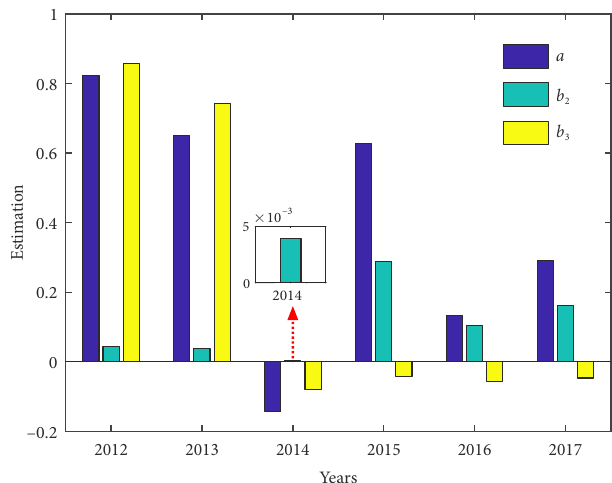
Figure 4. Description of model development coordination coefficient